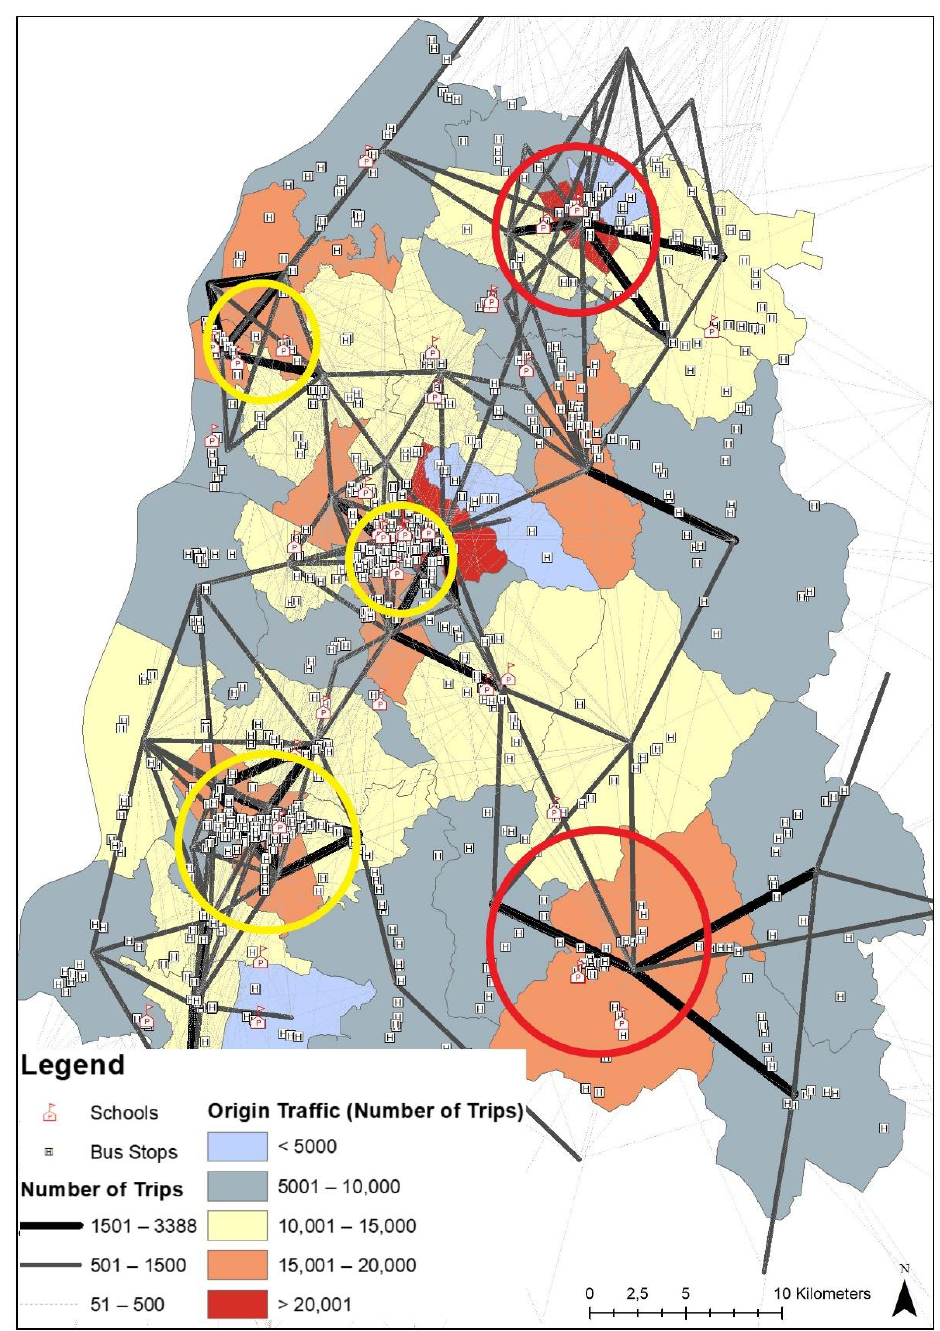
Figure 2. Connectivity and car dependency as the potential for modal shift.